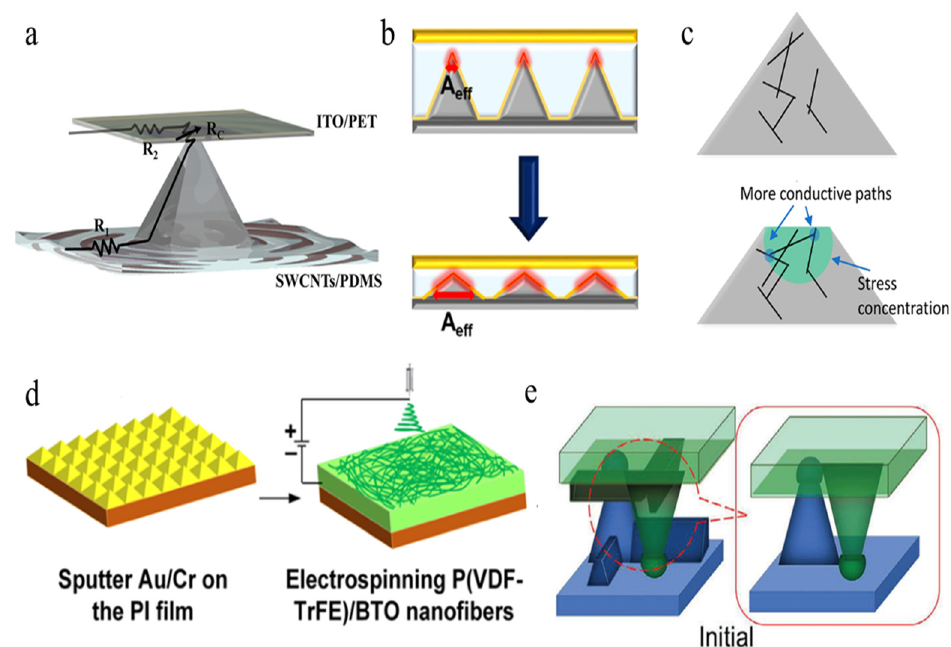
Figure 1. ( a ) Response mechanism of a SWCNT-coated polymer pyramidal pressure sensor [98]. ( b ) Mechanism of structural change of a transparent linear pressure sensor under pressure [99]. ( c ) Schematic of the conductive PDMS/CNT micropyramids, showing more conductive paths